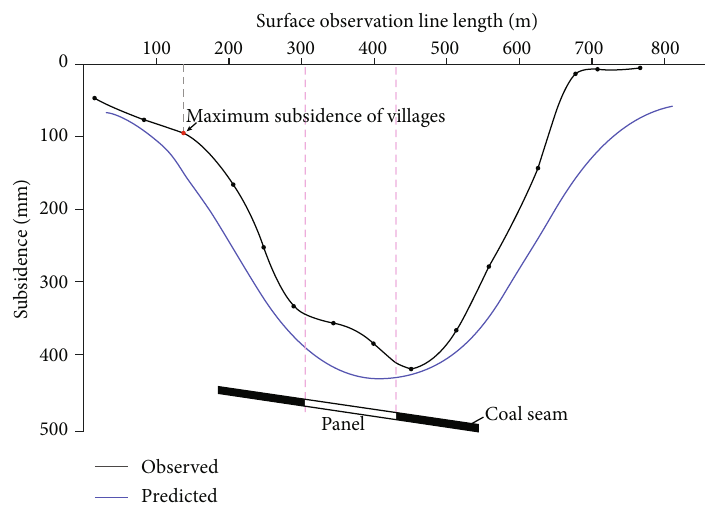
Figure 12: Comparison of predicted and observed surface subsidence with grouting. Table 4: Deformation of villages with grouting and protection